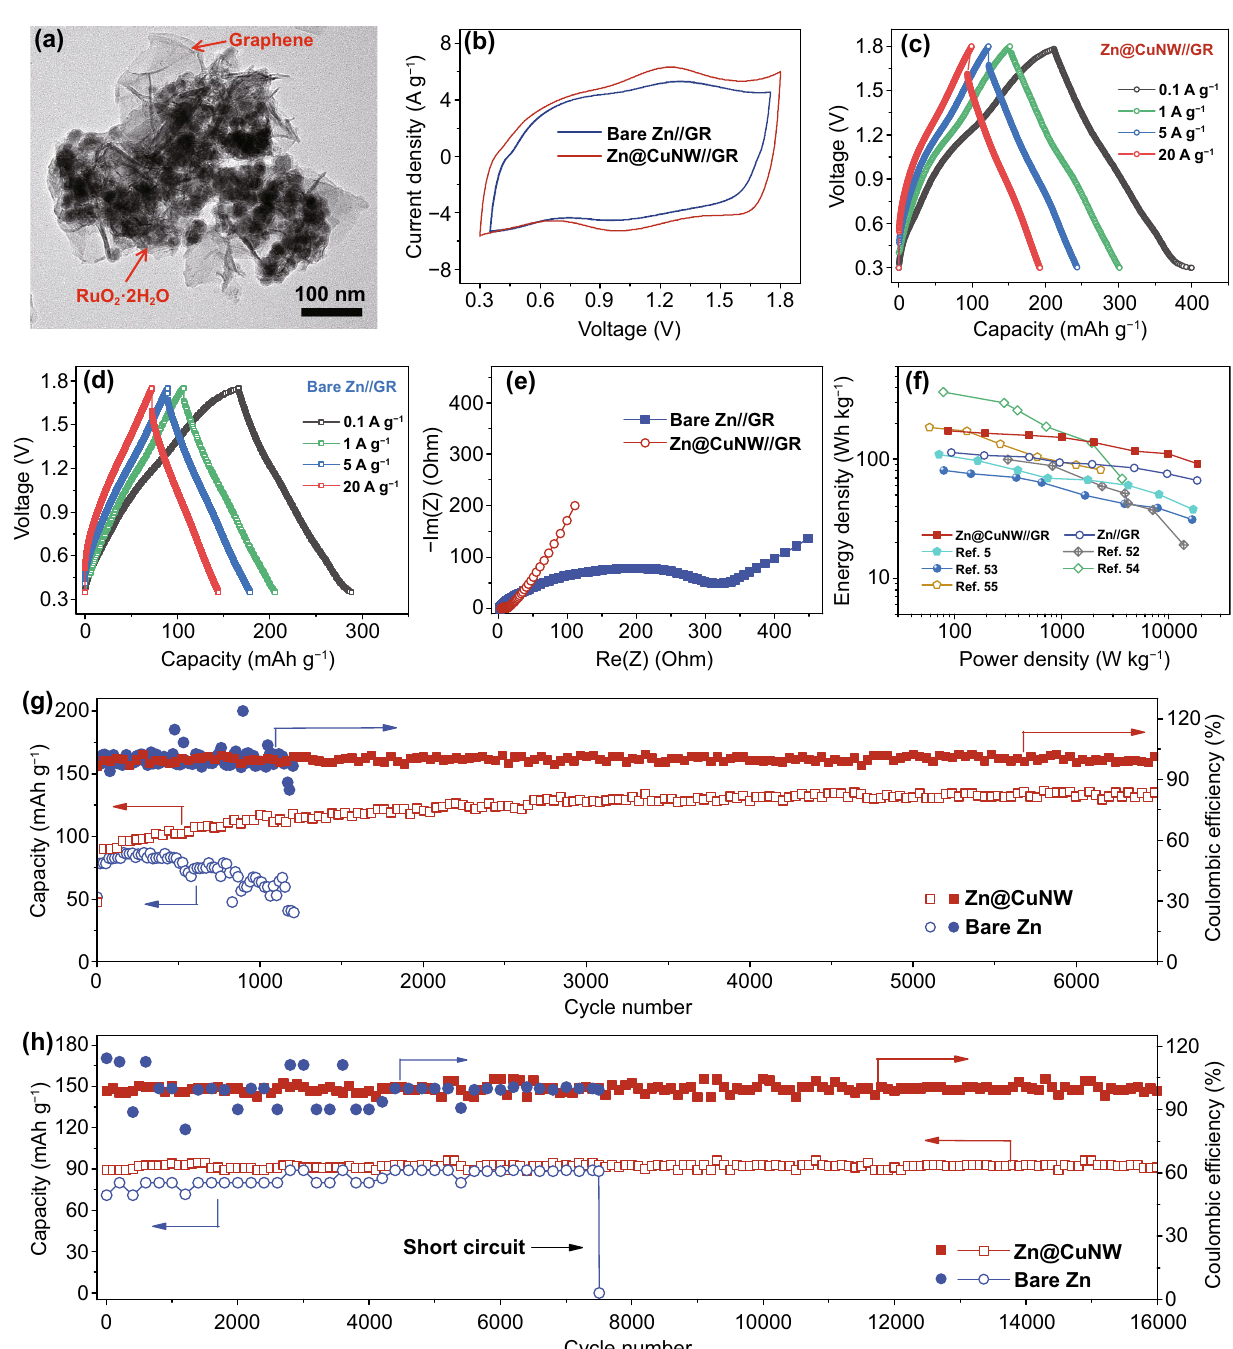
Fig. 5 a TEM image of the GR nanocomposite. Electrochemical properties of the Zn@CuNW//GR and the bare Zn//GR zinc-ion hybrid super- capacitors: b CV curves at 20 mV s −1 . c , d GCD curves at different current densities. e EIS spectra. f Ragone plots and long-term cycling behav- iors at g 5 and h 20 A g